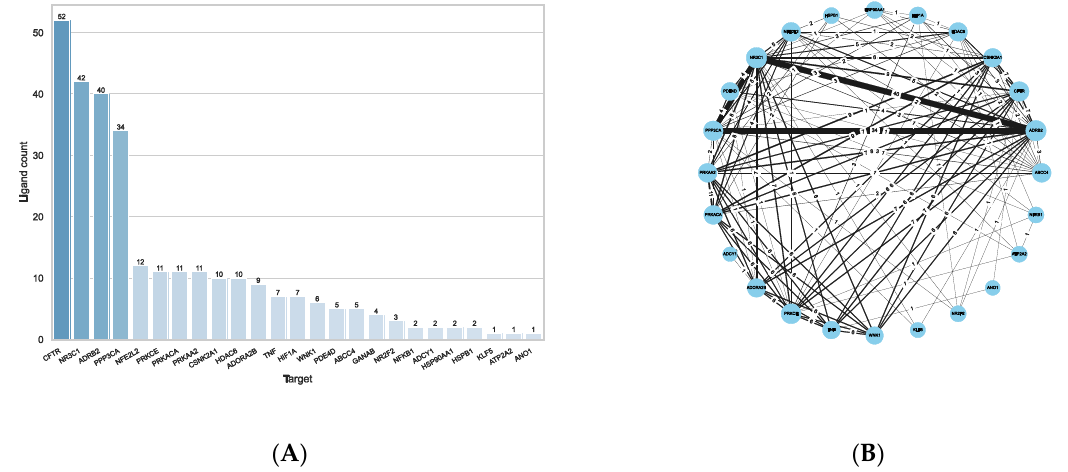
Figure 9. Results from the ligand-based approach using all targets. ( A ) Number of ligands associated with each target. ( B ) Protein – Ligand-Interaction network. Each nodes (circle) stands for one target, while the edges (lines) connecting them represent the number of common ligands (=number on edge) associated with them by either method. The thicker the edge, the more ligands two targets share. The size of the nodes represents their degree, i.e., the number of other nodes they are connected to.